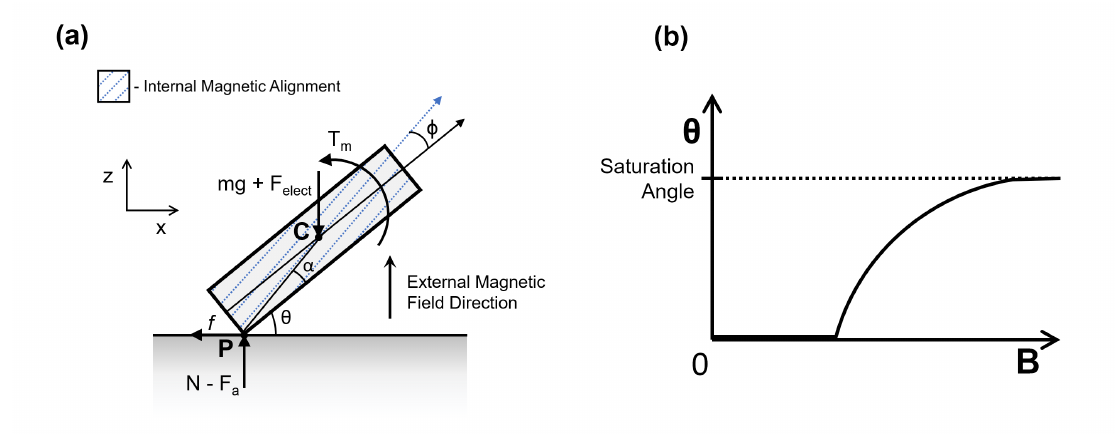
Figure 4. ( a ) Force diagram: Point C is the center of mass and Point P is the contact point. Note that adhesion force will act on the center of mass if the robot is resting flat on the ground. ( b ) General plot of magnetic field strength versus robot orientation